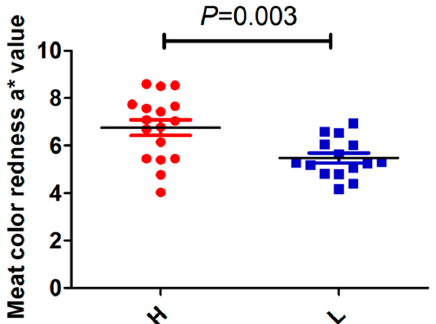
Figure 3. Comparison of meat color (redness) value a * between high and low groups. Thirty-two longissimus dorsi muscles were divided into two groups according the ratio of MyHC IIB to MyHC I expression (threshold value = 2.0). The ratios of > 2.0 and < 2.0 were defined as high meat color a * group (H) and low meat color a * group (L), respectively. Statistical analysis between the H and L groups was performed using the unpaired sample t test method in SPSS 20.0. Data are presented as the mean ± SEM (n = 17 for the H group and n = 15 for the L